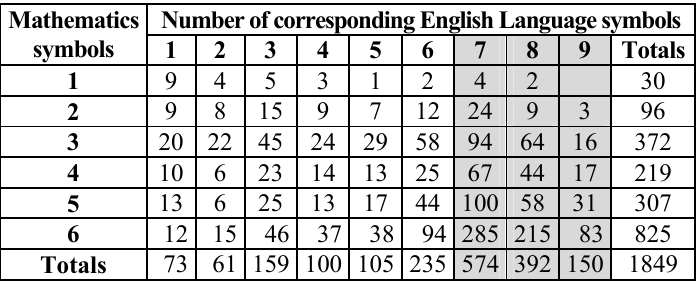
Table 3: A comparison of the GCE 2006 national English Language and Mathematics